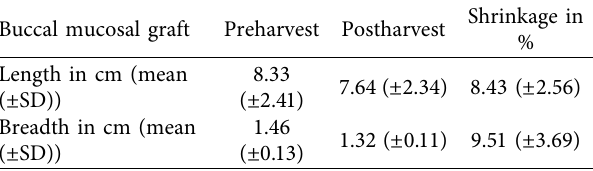
Table 2: Pre- and postharvest measurement of the graft. Buccal mucosal graft Preharvest Postharvest